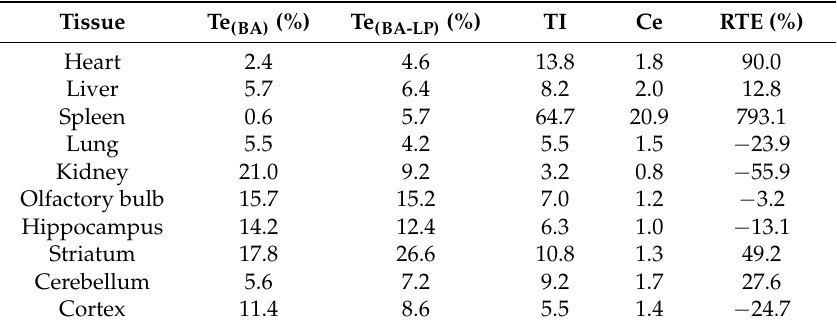
Table 6. The targeting parameters after intravenous administration with BA or BA-LP on the MCAO animal models.